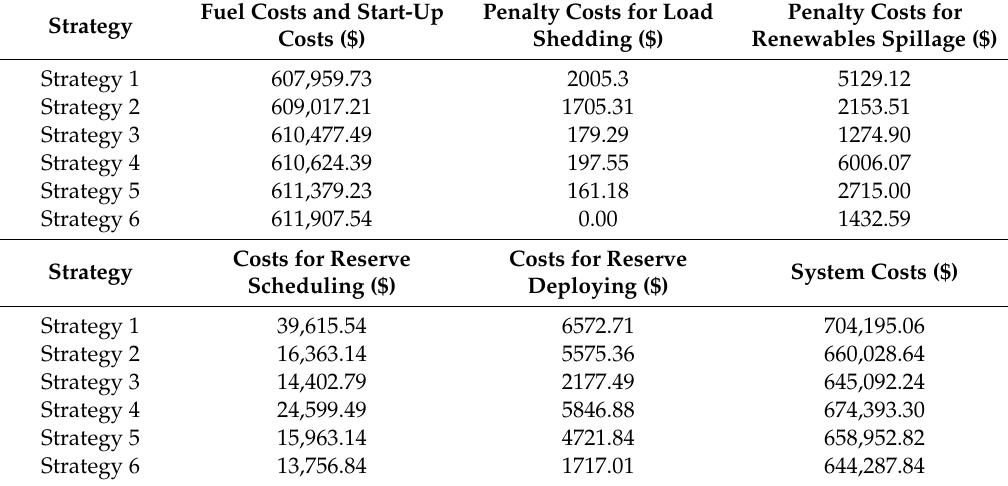
Table 6. Simulation results of system costs based on di ff erent reserve